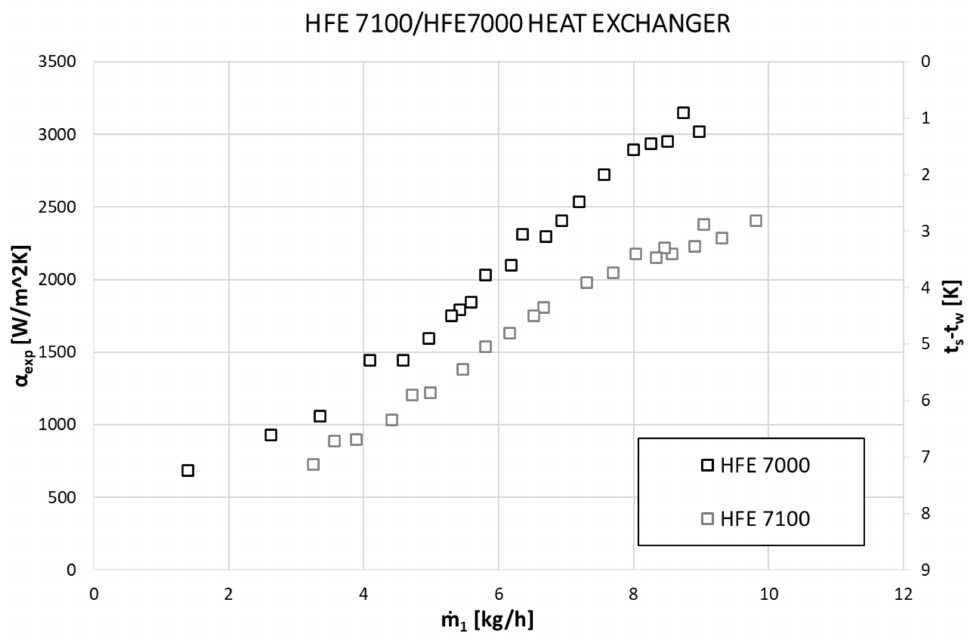
Figure 11. Experimental data on the dependence of the heat transfer coefficient α exp and the dif- ference between the saturation temperature of the refrigerant t s and the wall temperature of the minichannel t w on the mass flux flow of the refrigerant ˙m during the HFE 7000 and HFE 7100 refrigerants’